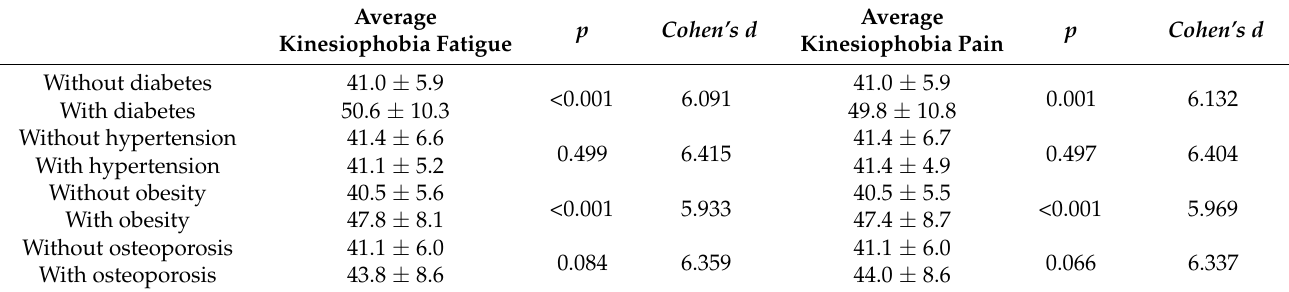
Table 7. The level of kinesiophobia and comorbidities.